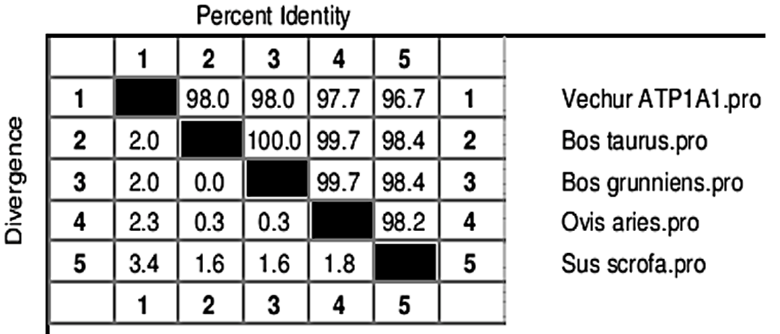
Figure 5. Percent identity (upper half) and divergence (lower half) of the predicted ATP1A1 protein sequence of Vechur cattle with similar sequences in the